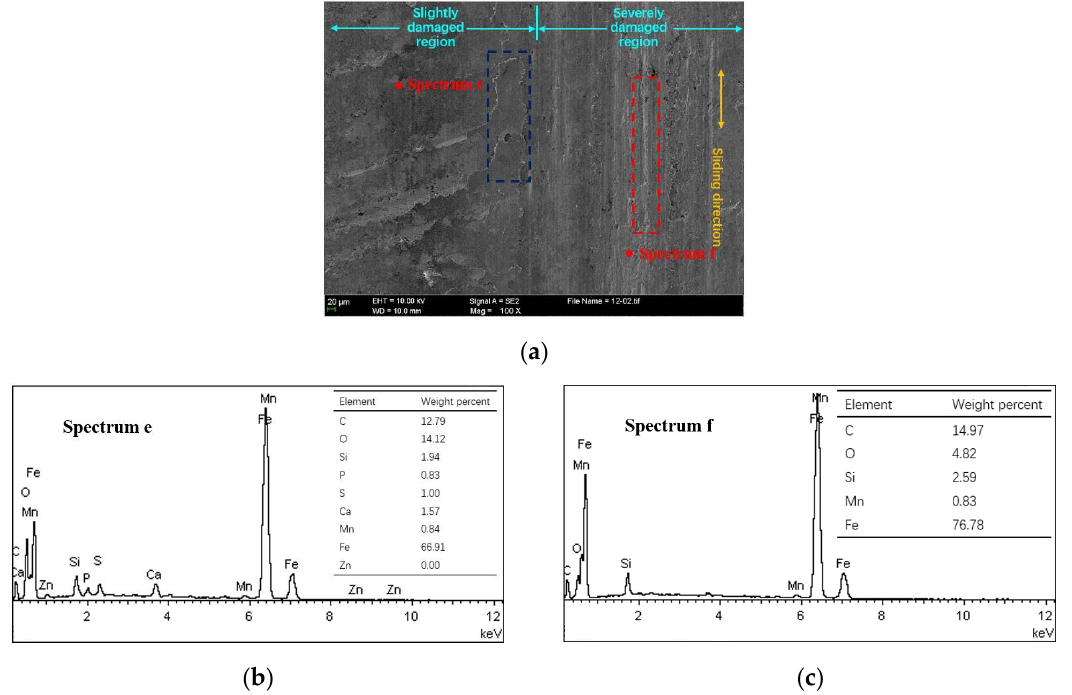
Figure 9. Scuffed cylinder liner surface and elemental content of CKS/Fe. ( a ) SEM image; ( b ) EDS spectrum e; ( c ) EDS spectrum f